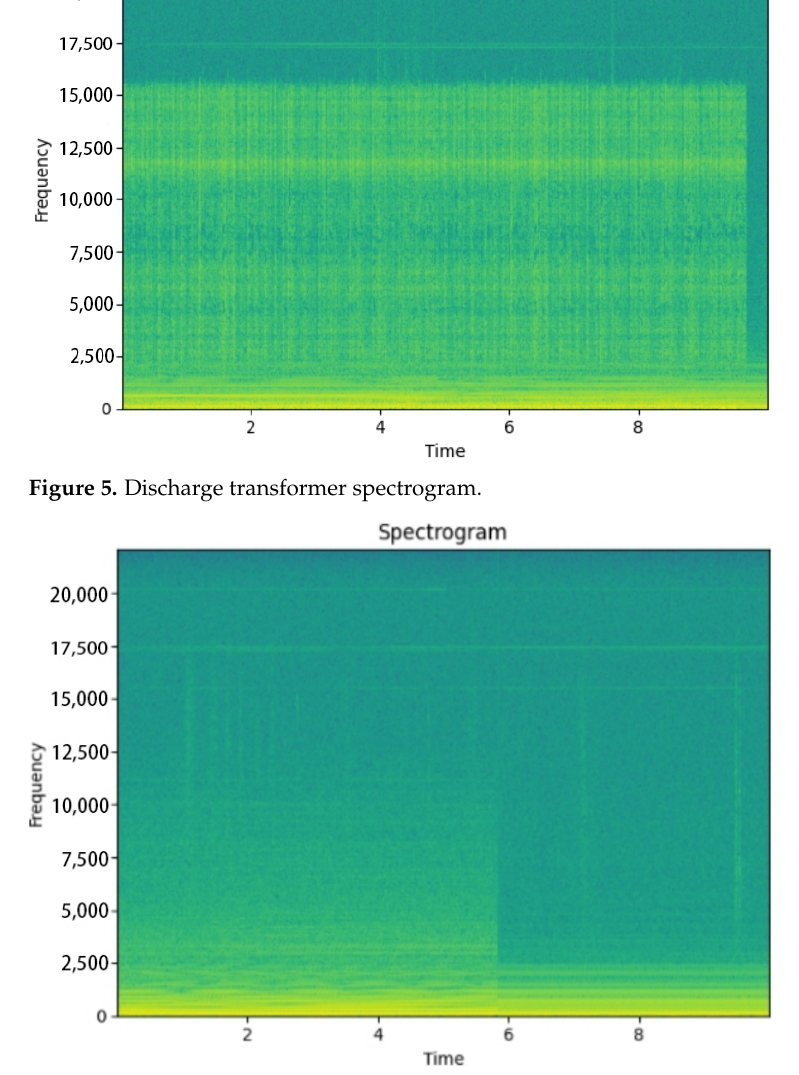
Figure 6. Overload transformer